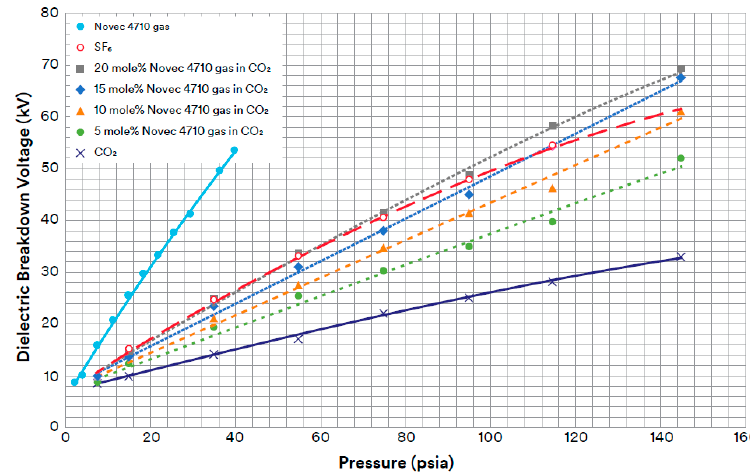
Figure 1. AC breakdown voltage depending mixture ratio and gas pressure [66].